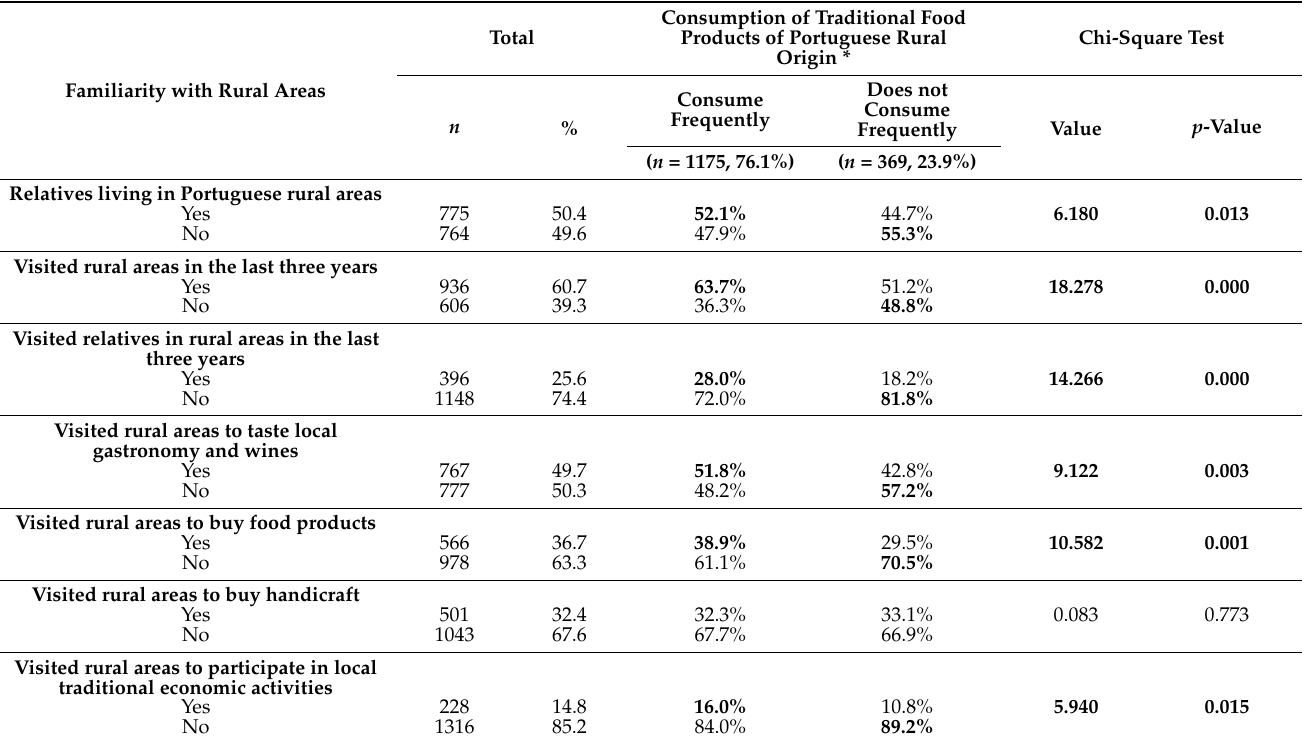
Table 6. Familiarity with rural